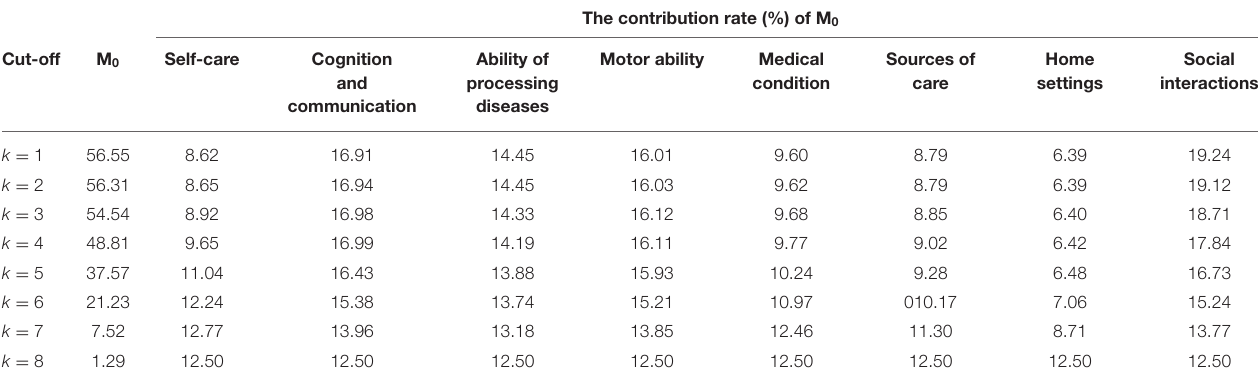
TABLE 3 | The contribution of multidimensional disability indexes (M 0 ).